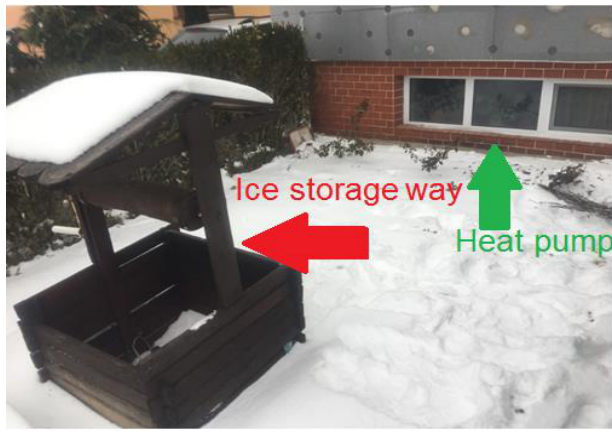
Figure A2. Location of system components .